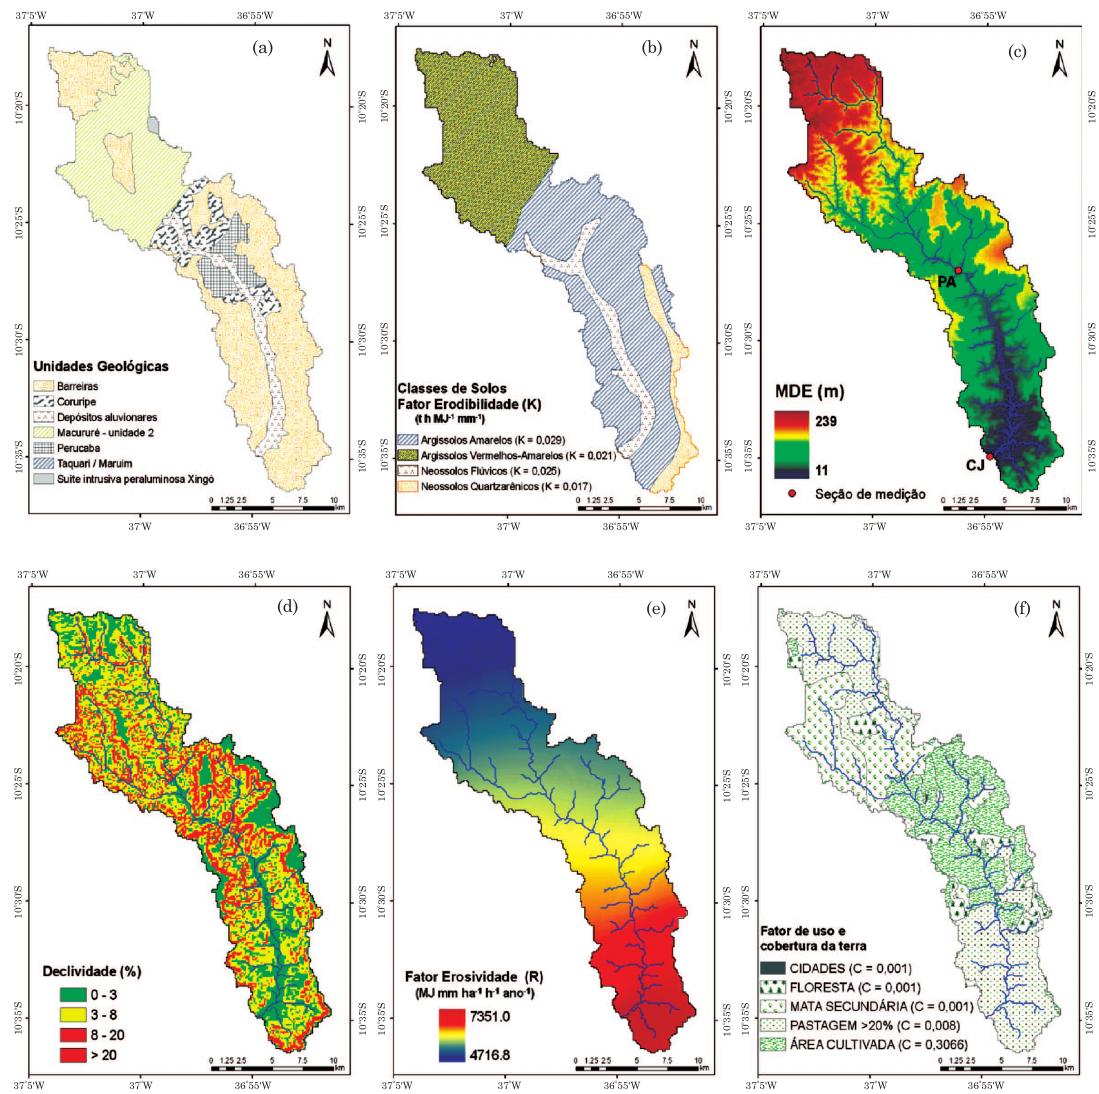
Figura 2. Mapas de unidades geológicas (a), classes de solos e fator erodibilidade - USLE (b), modelo digital de elevação (c), declividade (d), fator erosividade - USLE (e) e fator de uso e cobertura do solo - USLE (f), para a sub-bacia do Rio Japaratuba